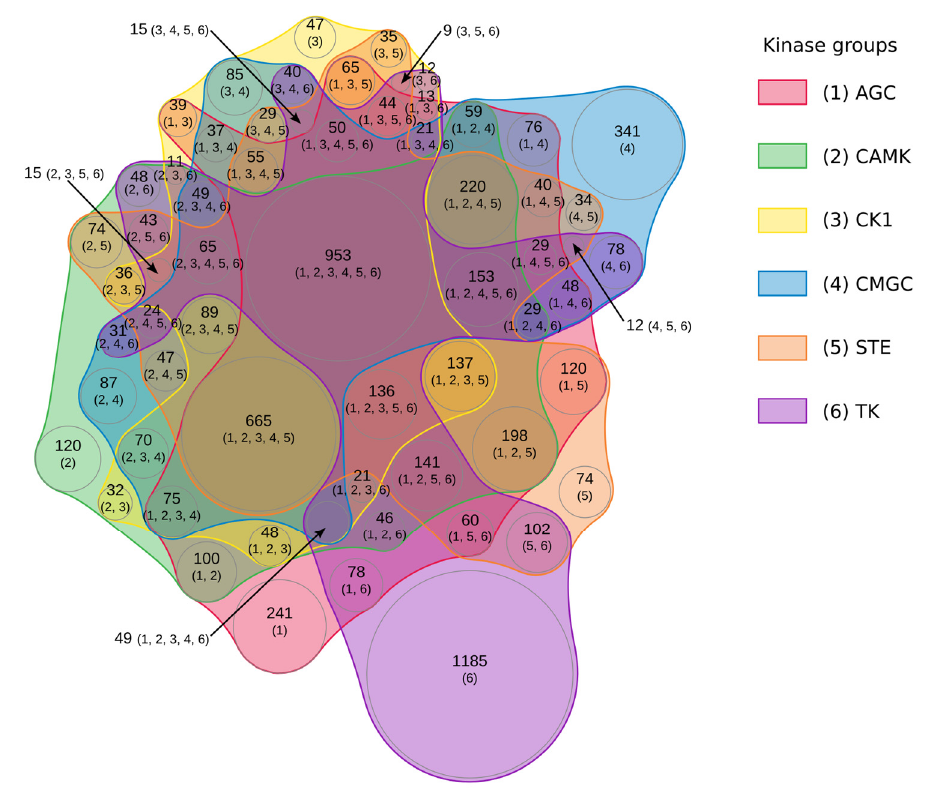
Figure 9. An euler diagram of the proteins phosphorylated by six major kinase groups. Euler diagram representation of the overlapping sets of proteins phosphorylated by the groups of kinases AGC, CAMK, CK1, CMGC, STE, and TK. In the figure, each kinase group is identified by a number between brackets (from 1 for AGC to 6 for TK). The number of proteins corresponding to each region of the diagram is specified, followed by the identifiers of the kinase groups that phosphorylate them. In dense areas, the content of some regions is taken out of the body of the diagram and linked to the corresponding region by arrows. The area of each region in the diagram is proportional to the number of elements included.